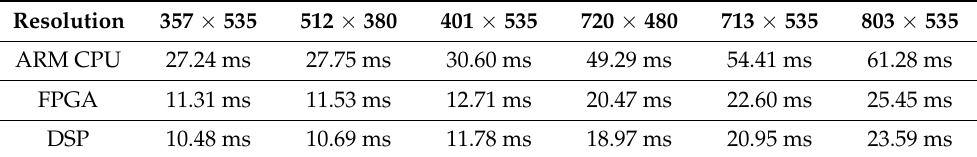
Table 3. The average computational time cost when running implementations on different hardware